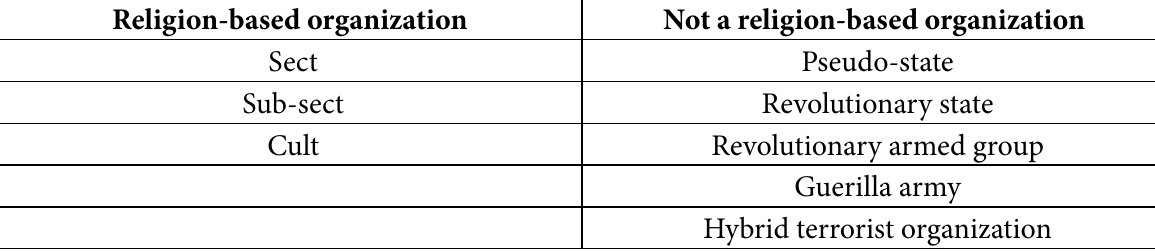
Table 1: Characterization of